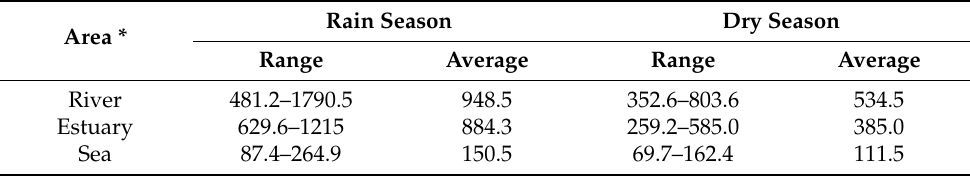
Table 1. The spatial distribution of microplastics in a coastal region of the PRE. Rain Season Dry Season Area * Range Average Range Average